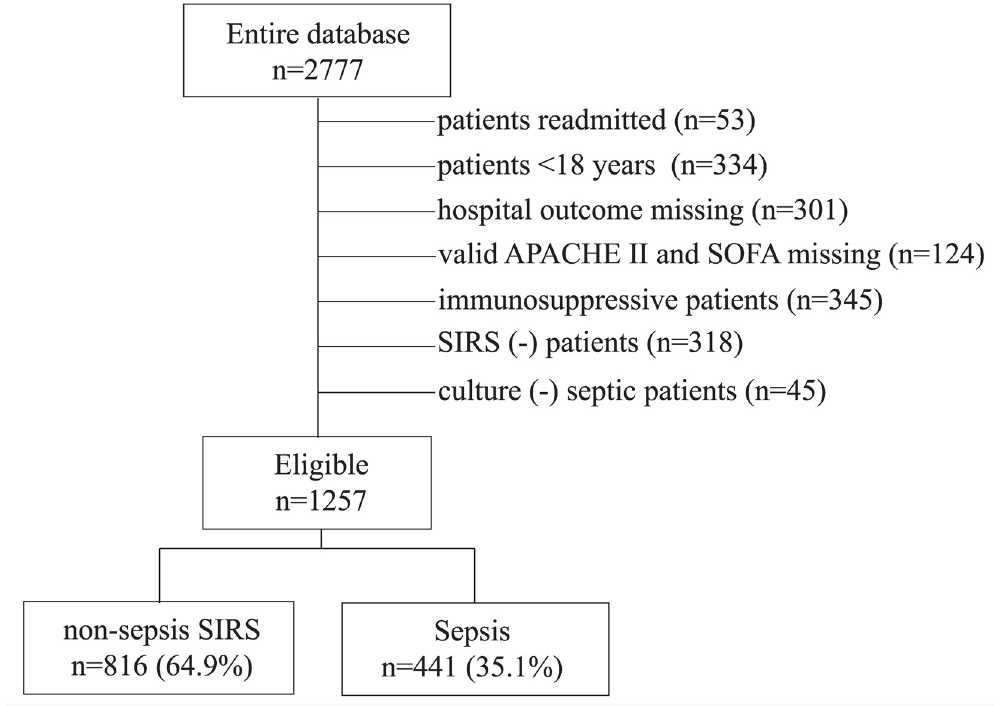
Fig 1. Study flowchart. Abbreviations: APACHE II, Acute Physiology And Chronic Health Evaluation; SIRS, systemic inflammatory response syndrome; SOFA, Sequential Organ Failure Assessment.